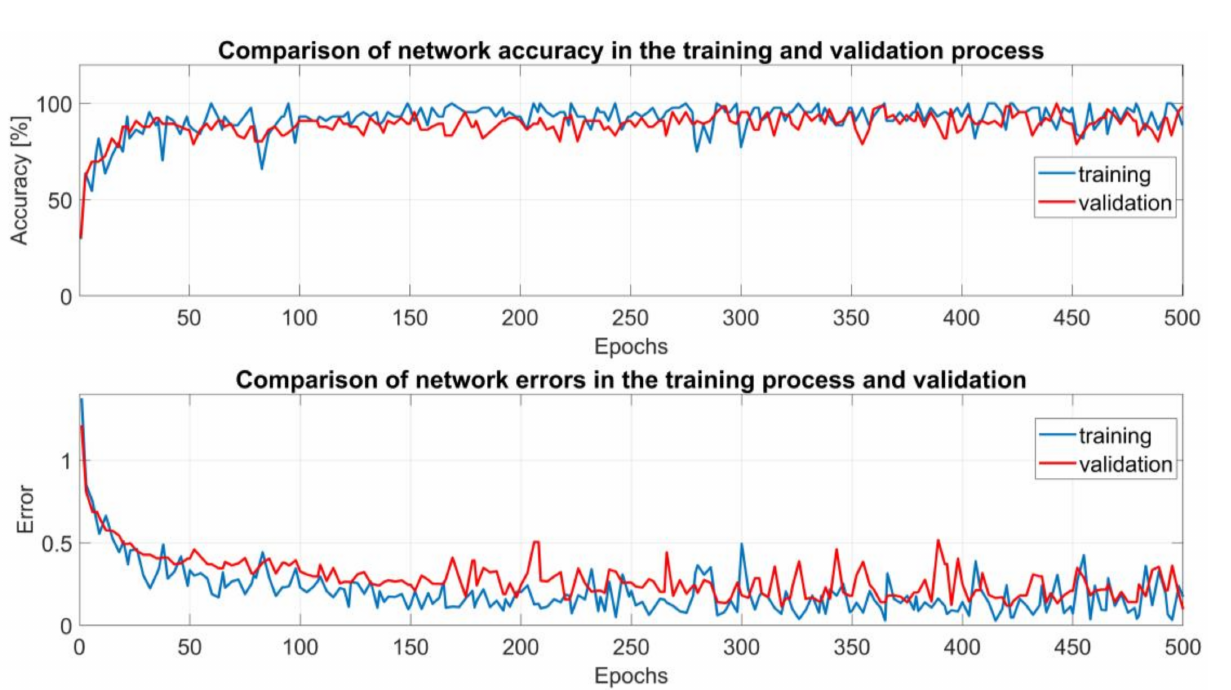
Figure 8. Waveforms of changes in accuracy and network error during training and validation process for the features of the received vibration